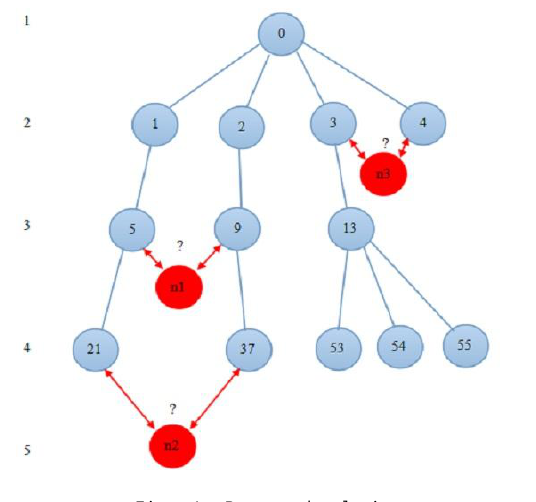
Figure 1. Parent node